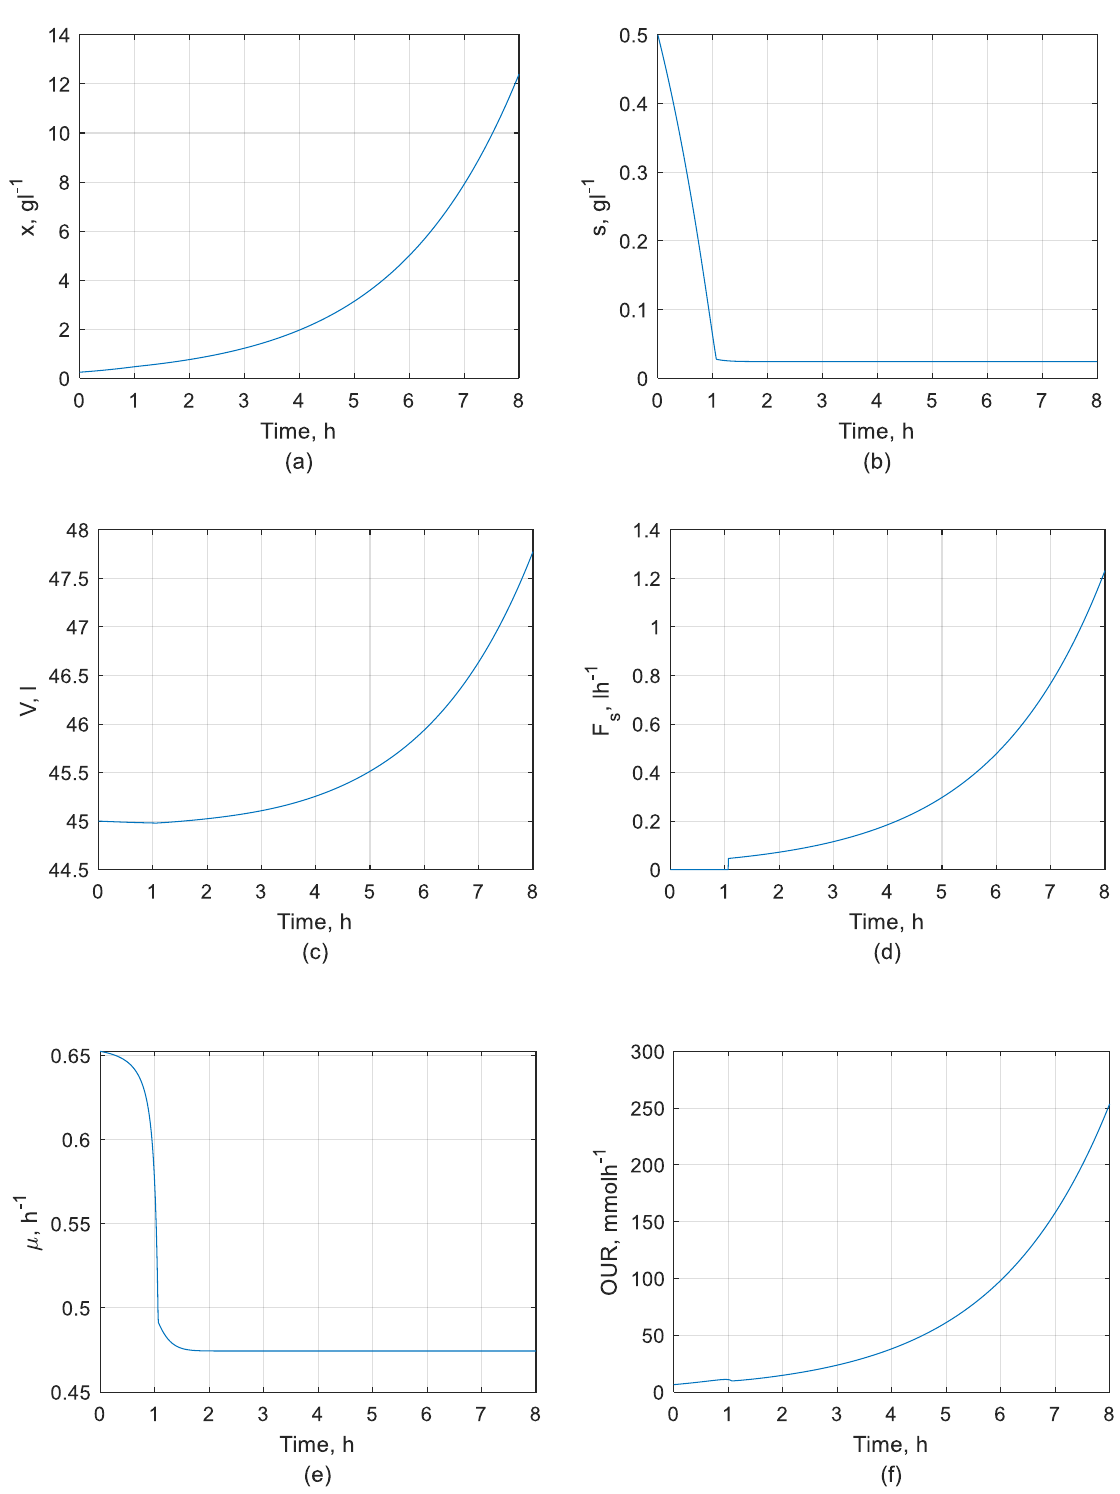
Figure 2. Trajectories of x ( a ), s ( b ), V ( c ), Fs ( d ), µ ( e ), and oxygen uptake rate ( OUR ) ( f ) during a DOC set-point tracking simulation run.